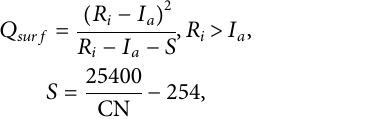
Frontiers in Earth Science |